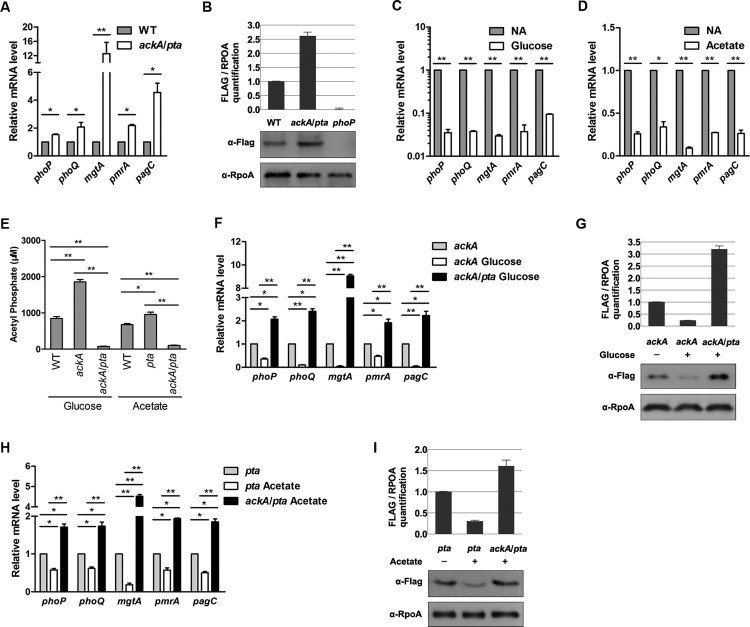
AcP regulates the mRNA level of PhoP target genes and protein levels of PhoP. A, Transcriptional levels of phoP/Q and downstream genes in wild-type strain and the ackA/pta mutant. B, PhoP concentration in the ackA/pta mutant strain. Relative Flag-tagged PhoP over RpoA was quantified (top panel). Error bars represent ± SD for triplicate experiments. C, The mRNA levels of phoP/Q and PhoP target genes in wild-type strain with or without glucose supplementation. Bacteria were harvested to extract RNA at the stationary phase in LB supplemented with 0.8% glucose. D, The mRNA levels of phoP/Q and PhoP target genes in wild-type strain with or without acetate supplementation. When bacteria grew to turbidity at 600 nm reached 0.4 in LB, 0.54% acetate was added and cultured for another 1 h. Then, bacteria were collected to extract total RNA. E, The intracellular concentrations of AcP in the ackA mutant with glucose supplementation or in the pta mutant with acetate supplementation. Bacteria were cultured in LB supplemented with glucose or acetate overnight and harvested for AcP measurement. Error bars indicate SDs of triplicate measurements. *, P < .05, Student’s t-test. F, The mRNA levels of phoP/Q and PhoP target genes in the ackA mutant. The stationary-phase bacteria in LB with or without glucose supplementation were harvested to isolate total RNA. The relative expression levels of the corresponding genes in the ackA mutant and ackA/pta double deletion mutant in the presence of glucose were compared with those in the ackA mutant without glucose supplementation (expression level set as 1). *, P < .05; **, P < .01, Student’s t-test. G, PhoP concentration in the ackA mutant. When the phoP-Flag strains grew to the stationary phase in LB with or without glucose supplementation, cells were harvested for western blotting. Western blot experiments were independently repeated at least three times. H, The mRNA levels of phoP/Q and PhoP target genes in the pta mutant. The transcriptional levels of phoP/Q and PhoP target genes in the pta mutant with or without acetate supplementation. When turbidity at 600 nm reached 0.4 in LB, acetate was added and cultured for another 1 h. Then, bacteria were collected to extract total RNA. *, P < .05; **, P < .01, Student’s t-test. I, PhoP concentration in the pta mutant. When bacteria grew to turbidity at 600 nm reached 0.4 in LB, acetate was added and cultured for another 1 h for Western blot. Western blot experiments were repeated three times. *, P < .05; **, P < .01, Student’s t-test.